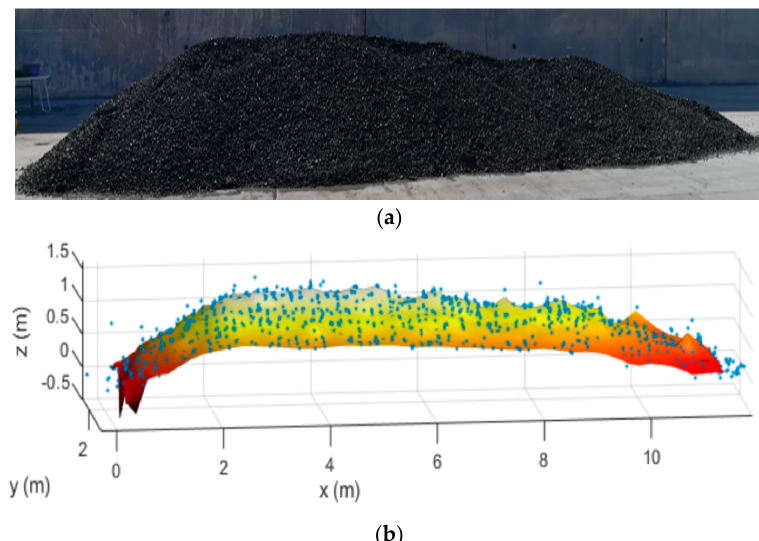
Figure 12. ( a ) Picture and ( b ) surface reconstruction of the stockpile.